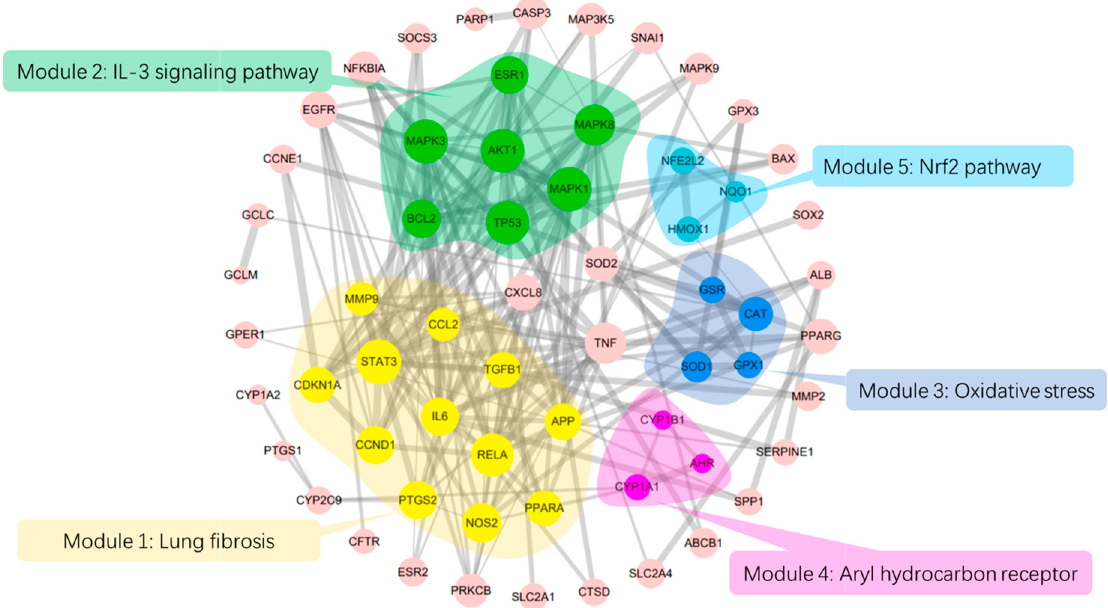
Figure 2. PPI network analysis and module analysis interaction targets. The size of the circles represents node degree value; the thickness of the edges represents combined score between two nodes.